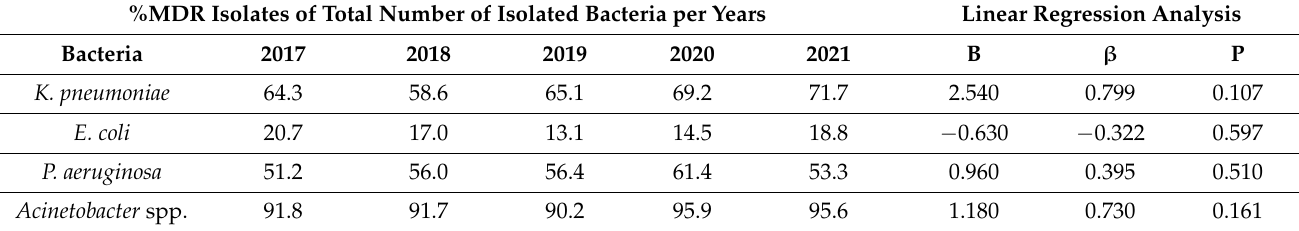
Table 4. MDR trend movements of selected bacteria in Serbia from 2017 to 2021.